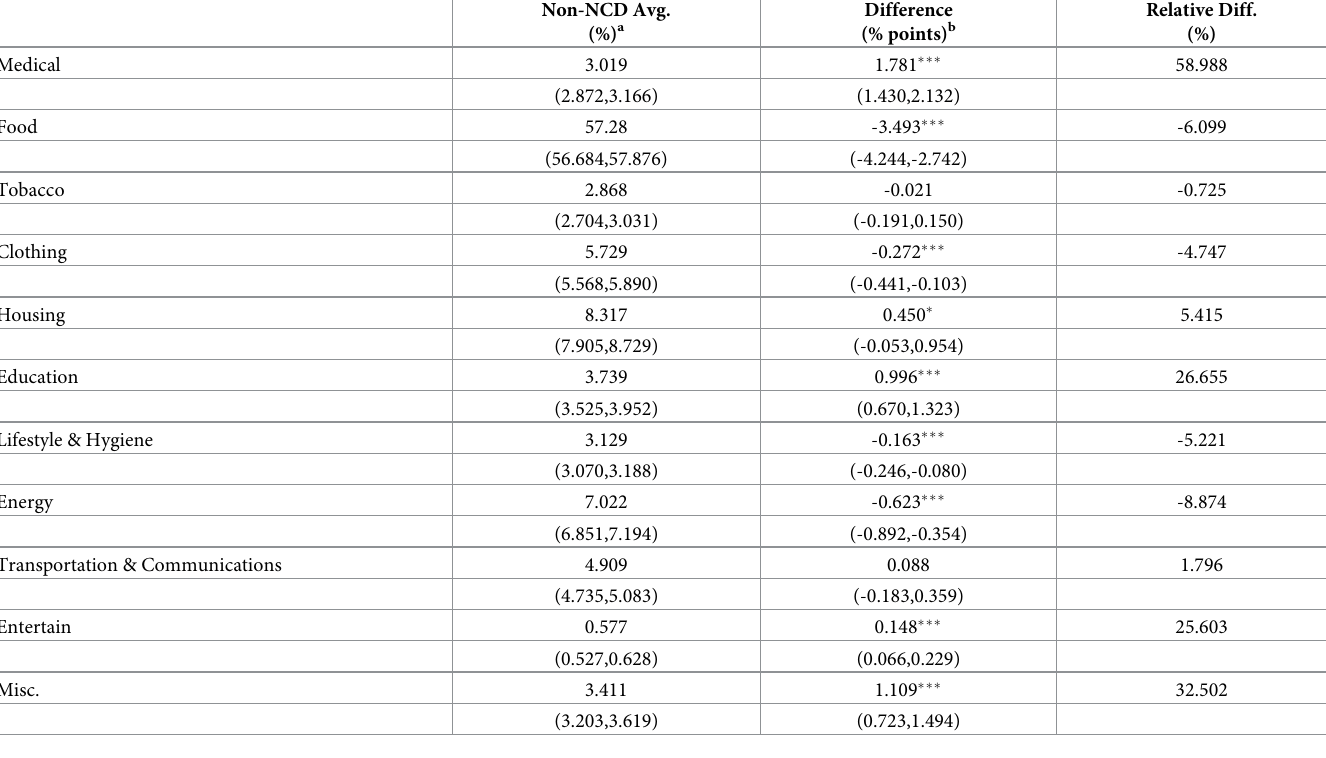
Table 2. Unadjusted differences in expenditure categories between NCD and non-NCD households.